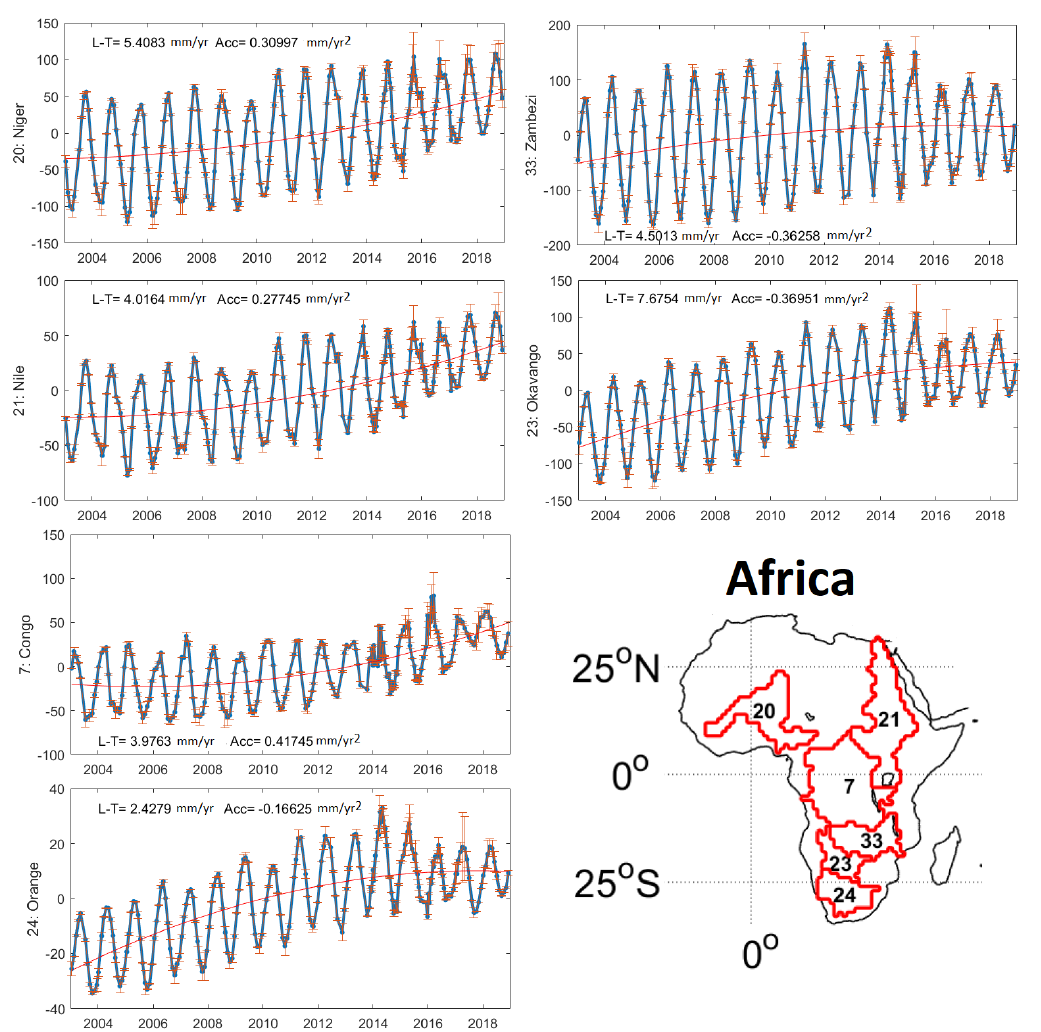
Figure 9. Basin averages of the reconstructed TWSC fields within the six major river basins of the African continent covering 2003–2018. The red lines show the long-term linear trend (L-T (mm/yr)) and acceleration (Acc (mm/yr 2 )) components fitted to the TWSC